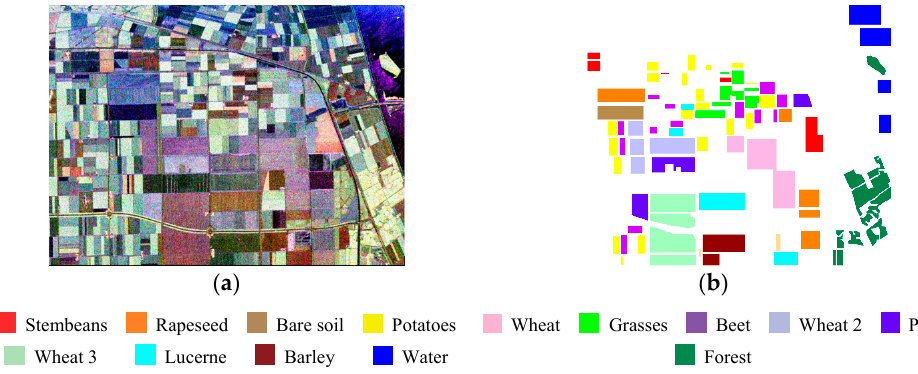
Figure 3. ( a ) Pauli RGB; ( b ) Ground truth; white area denotes unlabeled pixels.